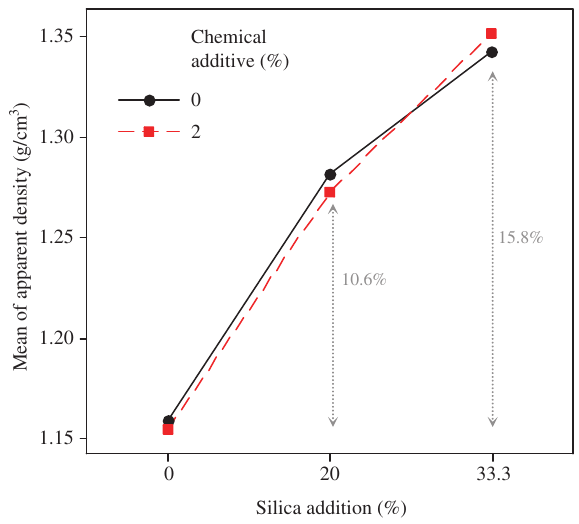
Figure 2 Interaction effect plot of silica addition and chemical additive for the apparent density response.